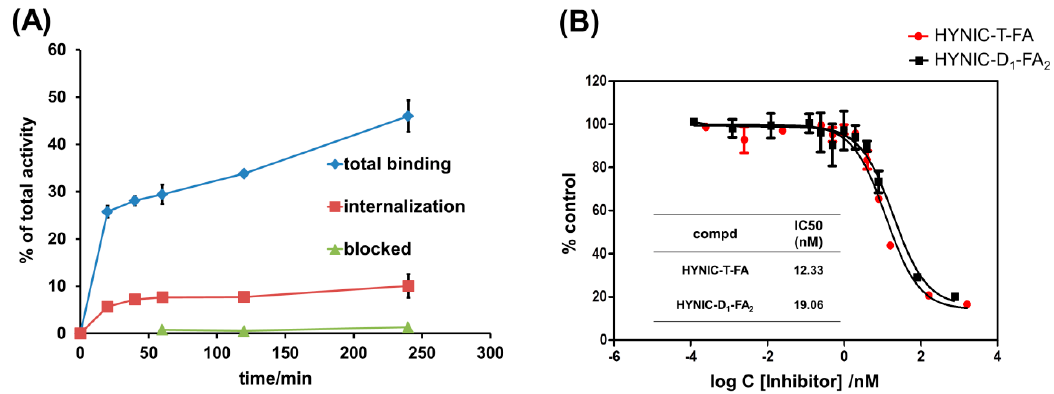
Figure 1. ( A ) The cell binding properties of 99m Tc-HYNIC-D 1 -FA 2 in KB cells (cell total binding, internalization and blocked by excess folic acid, p < 0.05). The cell binding was expressed as percentage of total added radioactivity; ( B ) in vitro inhibition of 125 I-tyr-FA binding to FR on KB cells by HYNIC-D 1 -FA 2 .